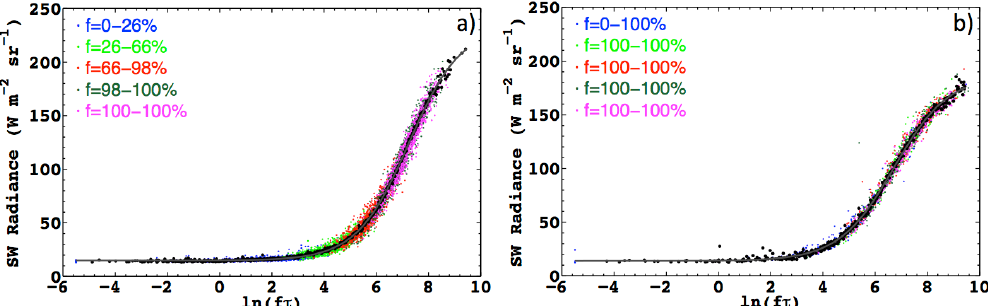
Figure 3. Relationship between SW radiances and ln (f e τ ) over ocean using CERES Terra measurements. (a) for liquid cloud in the angular bin of θ 0 = 44–46 ◦ , θ = 18–20 ◦ , and φ = 88–90 ◦ and (b) for ice cloud in the angular bin of θ 0 = 54–56 ◦ , θ = 14–16 ◦ , and φ = 176–178 ◦ . Colored dots are instantaneous SW radiances; black dots are mean SW radiances calculated for each 0.02 intervals of ln (f e τ ). Black lines are the sigmoidal fits.